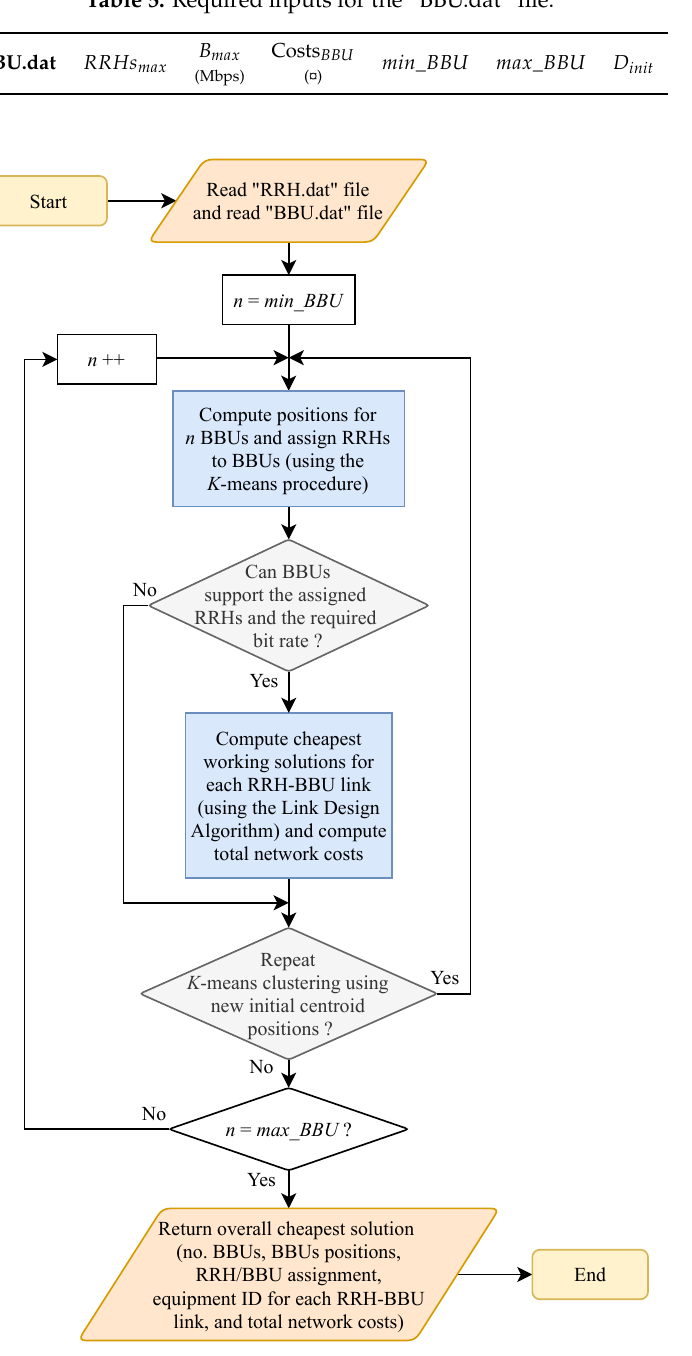
Table 5. Required inputs for the “BBU.dat” file.